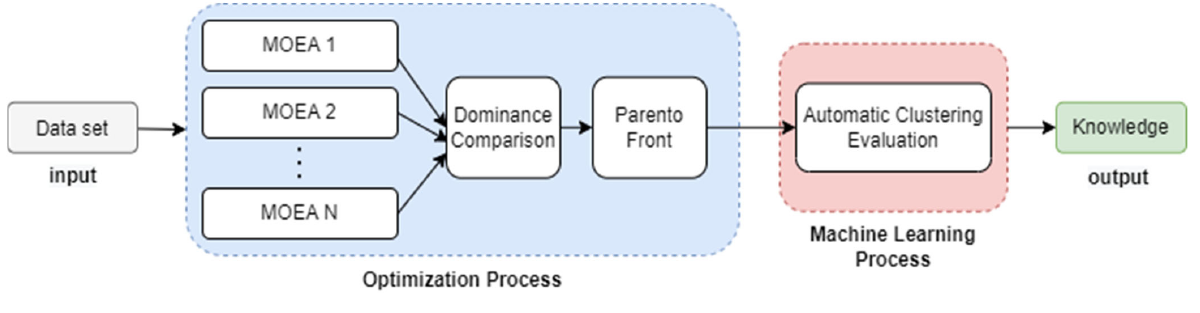
Fig. 1. Results obtaining